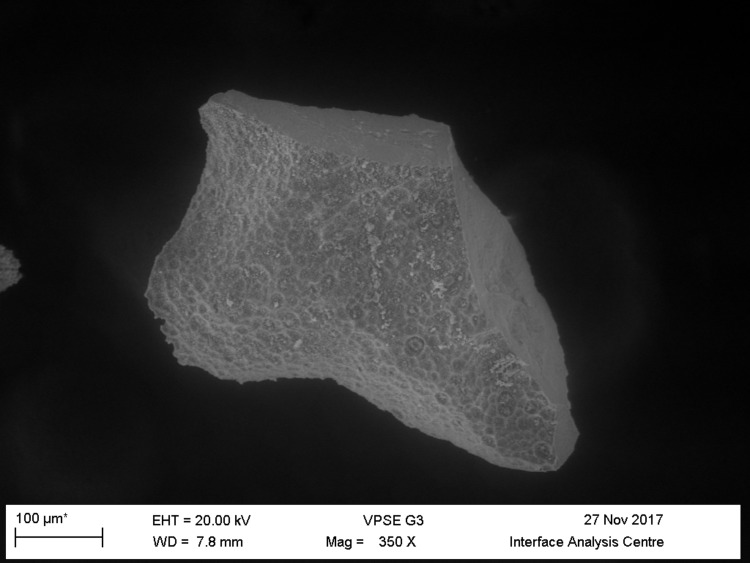
Mineral grain from demineralised Late Cretaceous Centrosaurus bone.